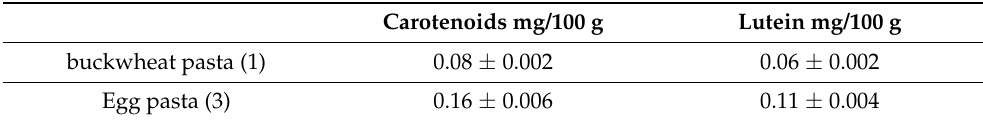
Table 2. Carotenoids and lutein content in cooked pasta samples. Data are the mean of three determinations (standard deviation < 5%).